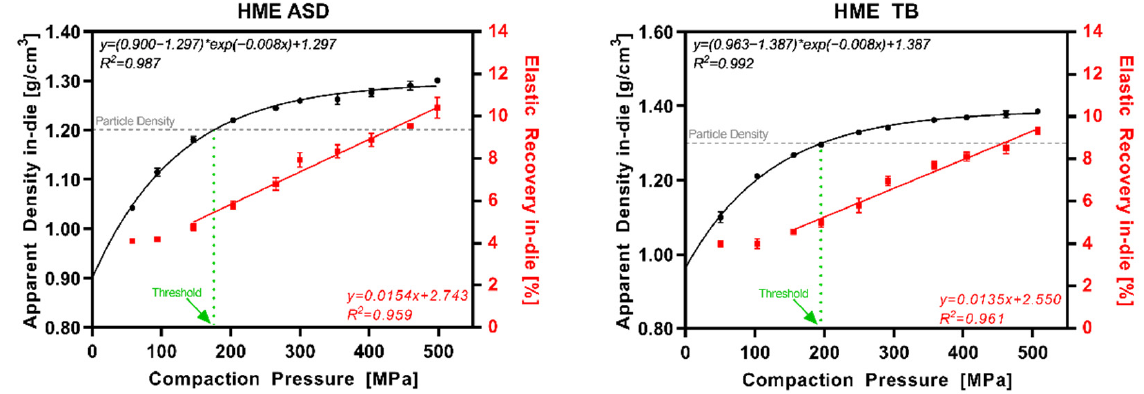
Figure 7. HME ASD and HME TB: apparent density in-die (black) and elastic recovery in-die (red) at different compaction pressures; particle density (grey dotted line); threshold in CP where ρ app = ρ par (green dotted line).